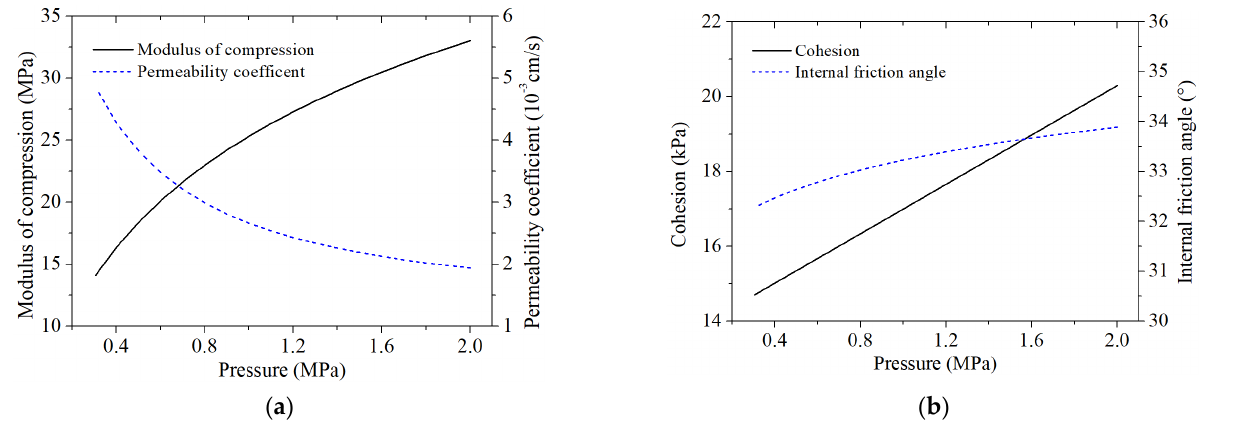
Figure 12. Relationship between performance parameters of sand and compaction pressure. ( a ) Modulus of compression and permeability coefficient. ( b ) Cohesion and internal friction angle.